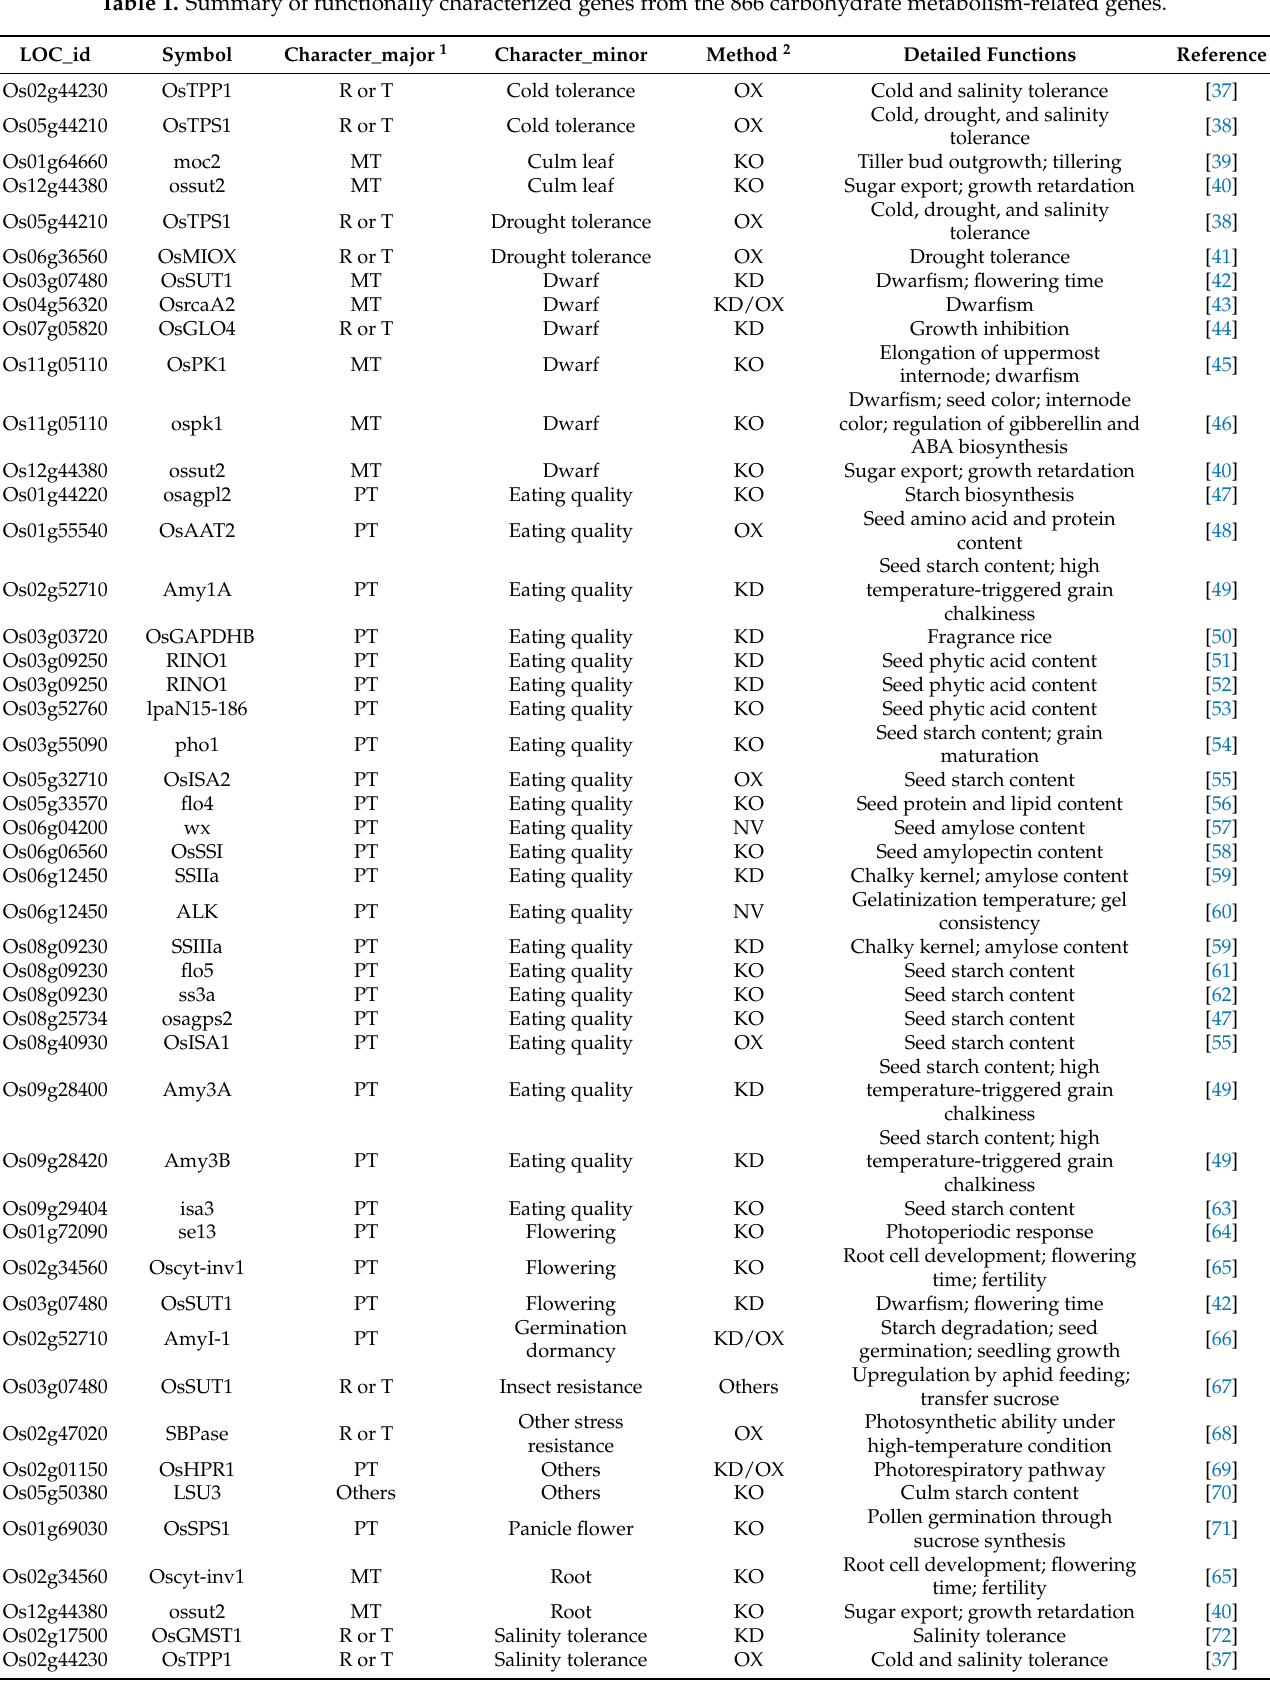
Table 1. Summary of functionally characterized genes from the 866 carbohydrate metabolism-related